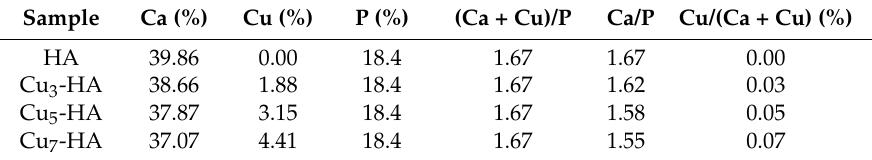
Table 1. Chemical components (% weights ± 0.05) of hydroxyapatite (HA) solutions. Sample Ca (%) Cu (%) P (%) (Ca + Cu)/P Ca/P Cu/(Ca + Cu) (%) HA 39.86